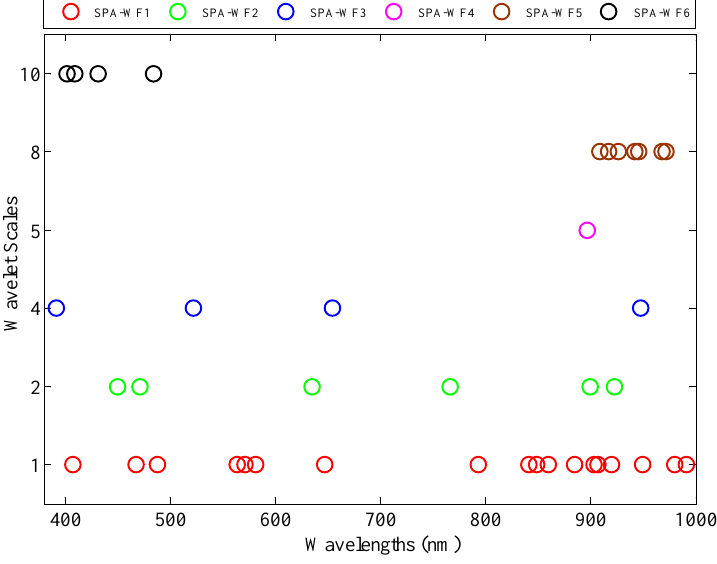
Figure 9. The location of growth stage-sensitive wavelet features selected by SPA.